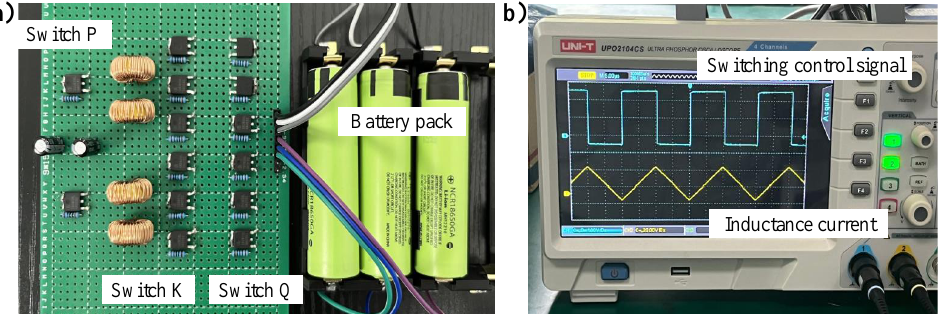
( a ) Physical circuit diagram and ( b ) waveforms of switching control signal and inductor